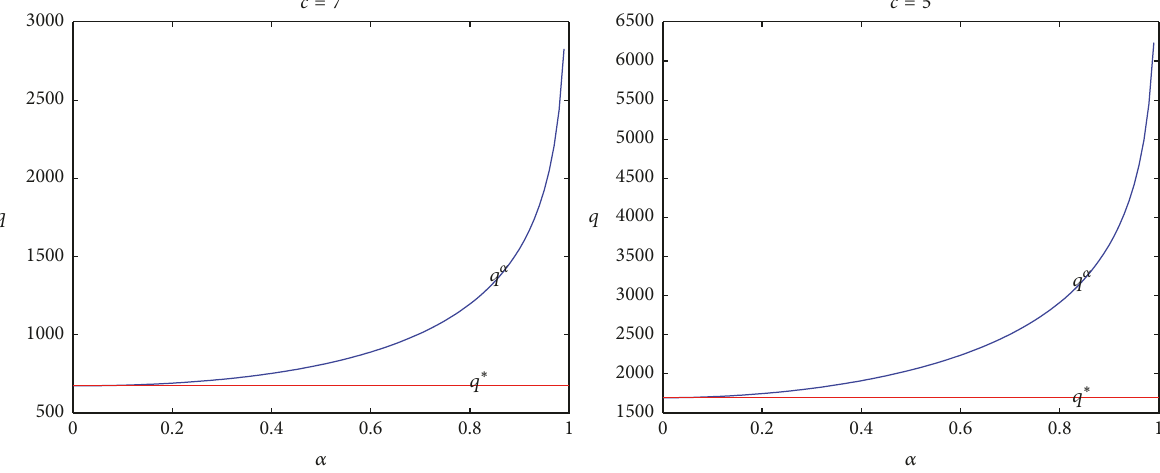
Figure 2: Optimal order quantity 𝑞 𝛼 or 𝑐 = 7 and 𝑐 = 5 when market demand follows the exponential distribution 𝐸(0.0005)